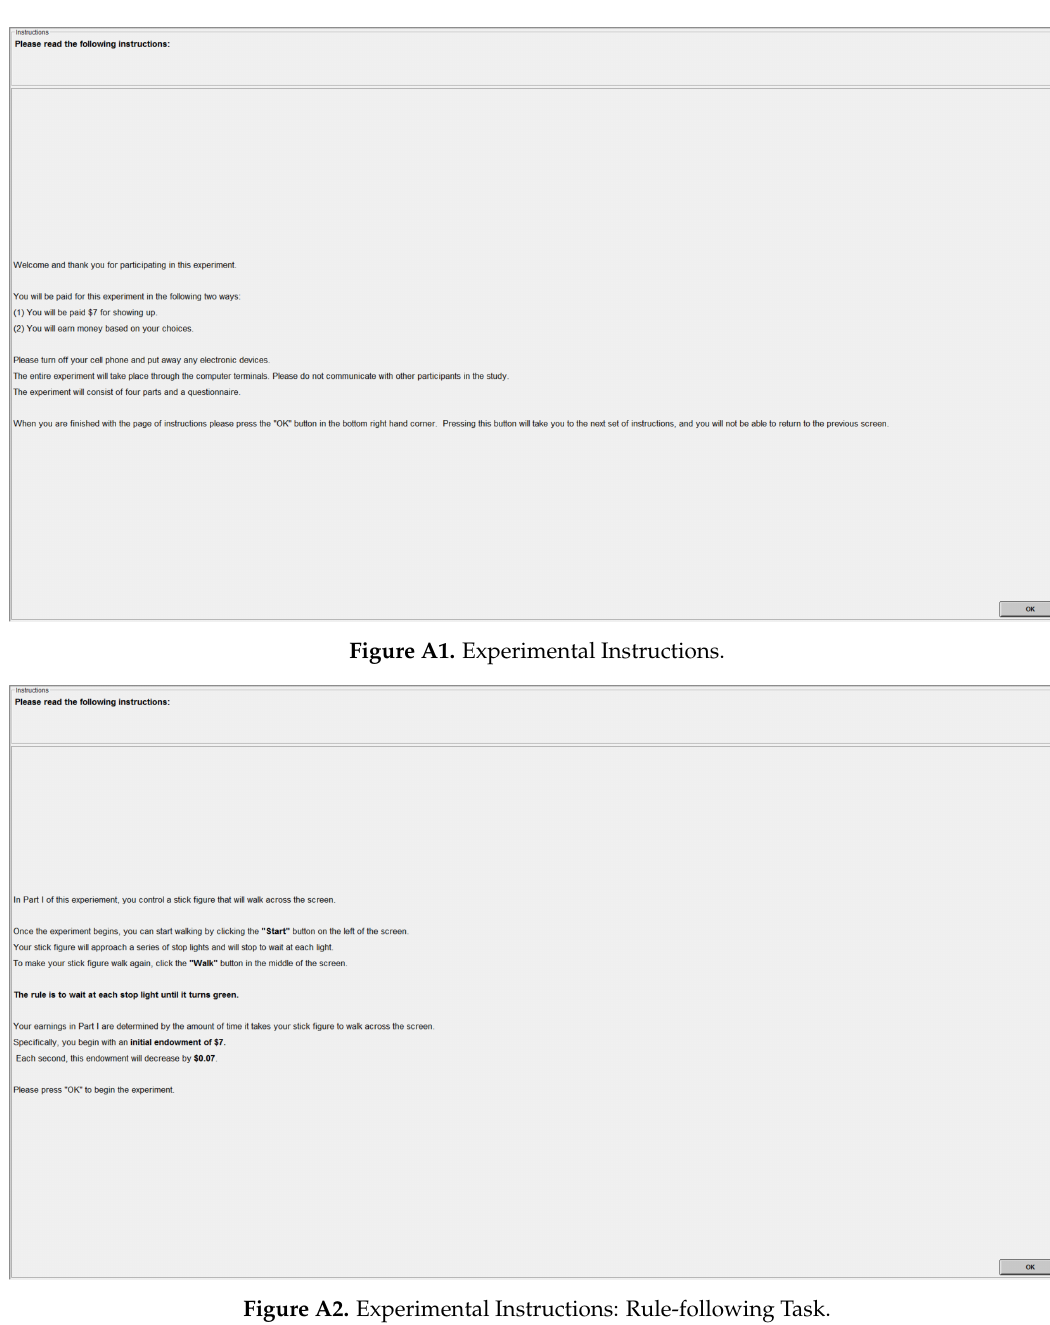
Figure A2. Experimental Instructions: Rule-following